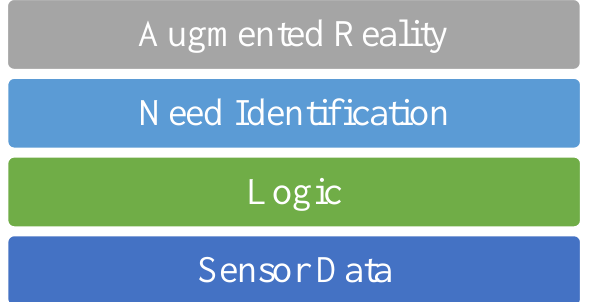
Figure 3. Layers of functionality in the proposed application.